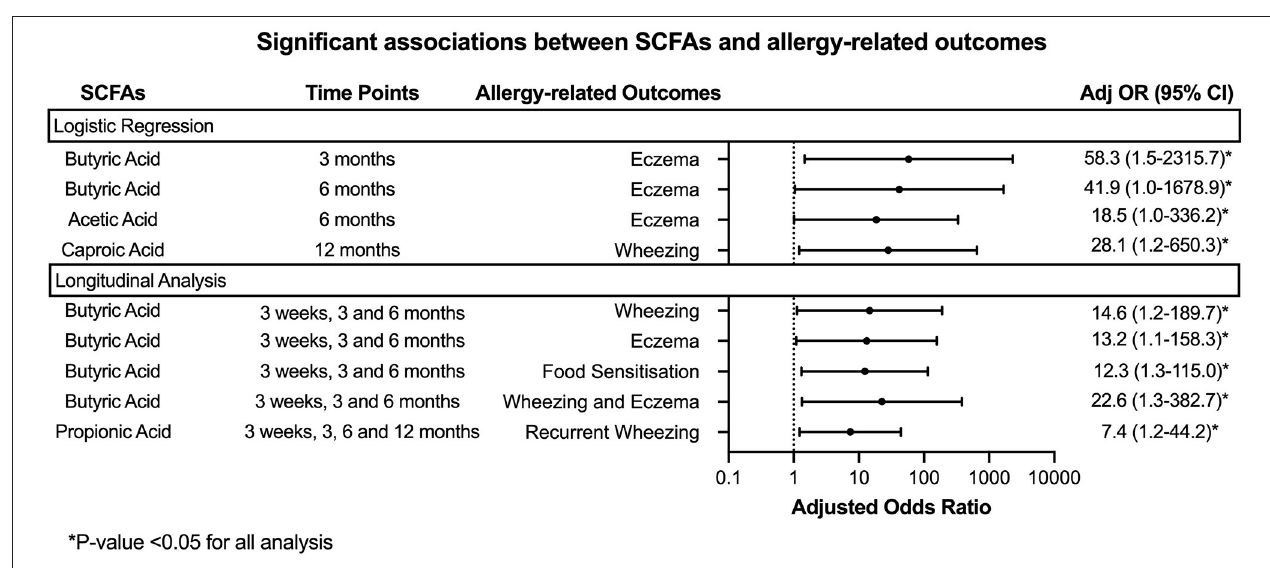
FIGURE 3 | Forest plot denoting the significant results from the analysis of stool SCFAs with allergy-related outcomes. Logistic regression and Generalized Linear Mixed Models were employed to analyse the association between SCFA concentration at each time point or longitudinally with the allergy-related outcomes. The analysis was adjusted for gender, presence of siblings, mode of delivery, family history of atopic diseases and feeding pattern (exclusively breastfeeding, partially breastfeeding or exclusively formula in the first 6 months of life).